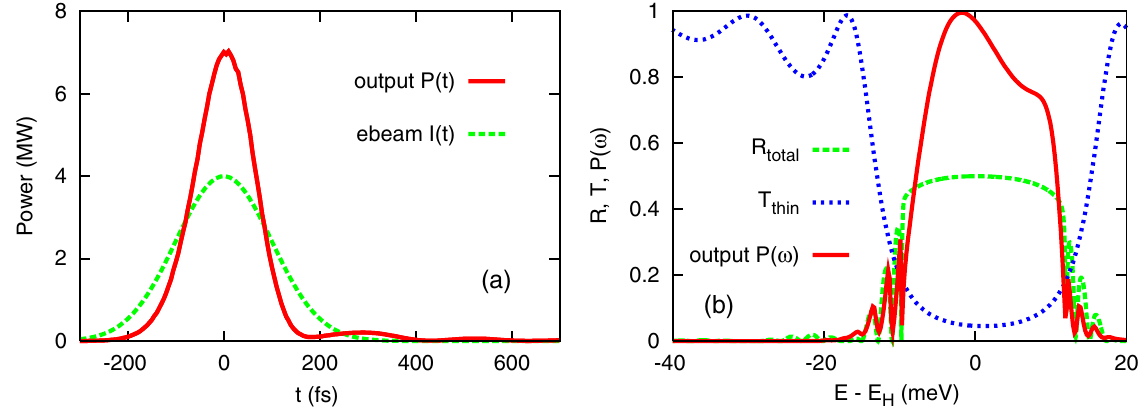
FIG. 9. Time and spectral profiles of the output radiation using a 100 fs electron beam and the parameters listed in Table II. In panel (a), the temporal profile shows (cid:1) 7 MW peak power in a nearly Gaussian first pulse; the subsequent pulse train is related to multiple reflections from the crystal surface. Panel (b) shows the spectral properties of the cavity reflectivity R and the transmission with the dotted (blue) line. The spectrum of the cavity pulse just fits within the crystal bandwidth, which leads to a similar shaped transmitted spectrum shown by the solid (red) line. Because the transmission of the thin crystal increases near the edges, the transmitted pulse spectrum is slightly distorted; nevertheless the spectrum is nearly single peaked, with a FWHM (cid:1) 18 meV and a